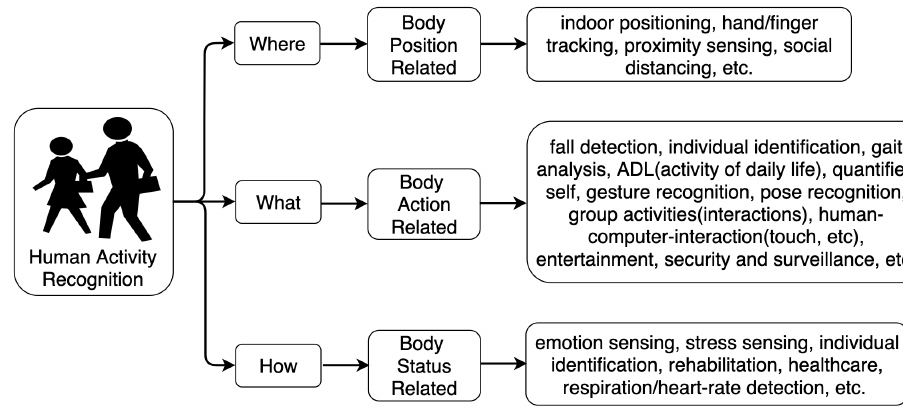
Figure 2. Categorization of human